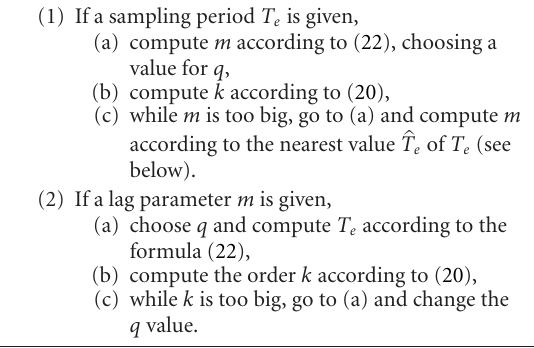
Algorithm 1: General procedure of the proposed